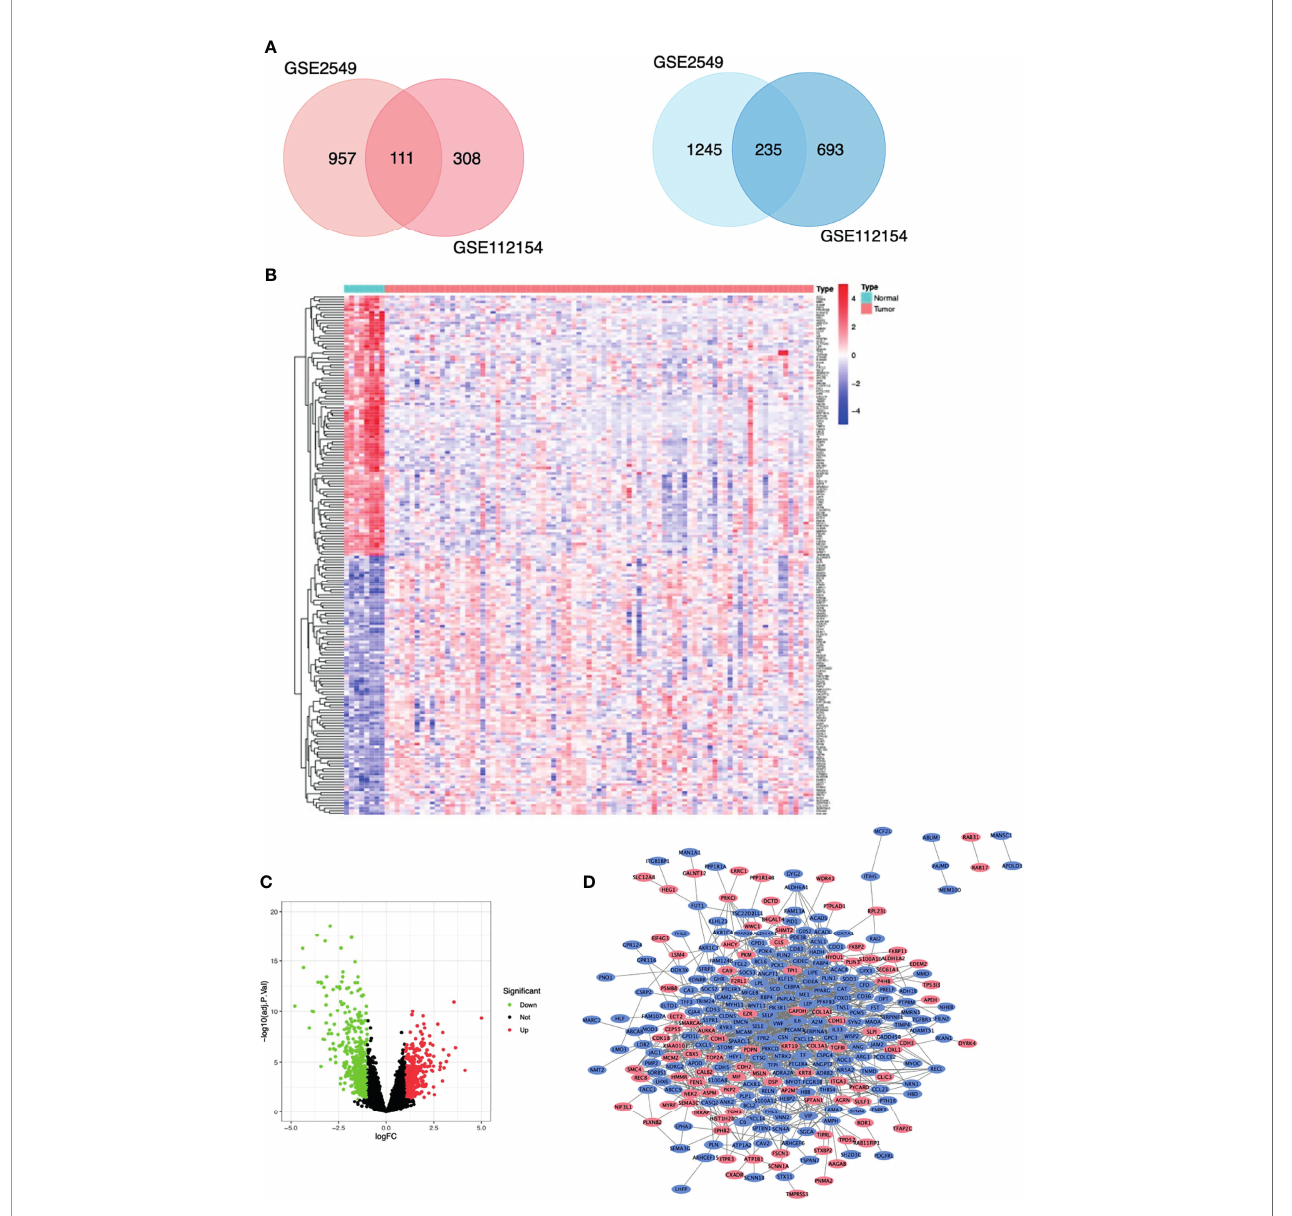
FIGURE 1 | Differentially expressed genes (DEGs) in patients with malignant mesothelioma. (A) Venn diagram of DEGs among the mRNA expression pro fi ling sets GSE2549 and GSE112154. Blue denotes downregulated genes, and red denotes upregulated genes showed. (B) Hierarchical heat map of TOP100 DEGs between malignant mesothelioma and normal mesothelial tissues. (C) Volcano plot of all DEGs between malignant mesothelioma and normal mesothelial tissues. (D) Protein- protein interaction network constructed with DEGs using Cytoscape. Red nodes represent upregulated genes, and blue nodes represent downregulated